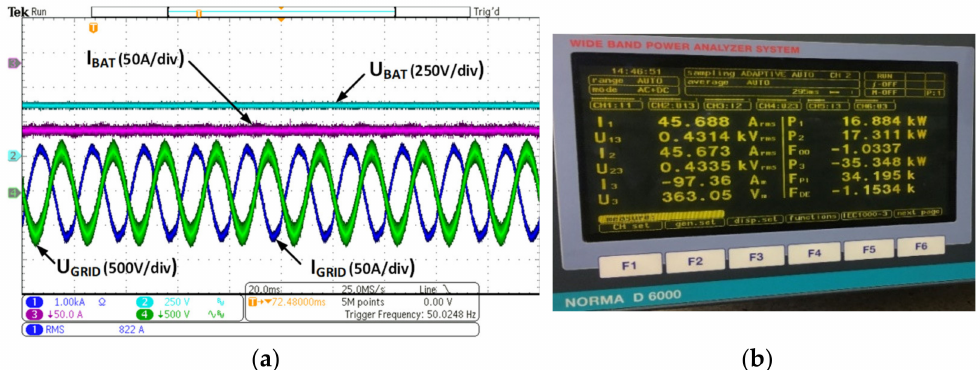
Figure 16. Operation of the bidirectional charger under nominal conditions—steady-state, discharg- ing mode: ( a ) current and voltage waveforms, from the top: battery current (purple), battery voltage (light blue), AC phase current (dark blue), AC line-to-line voltage (green); ( b ) printed screen from the LEM NORMA power